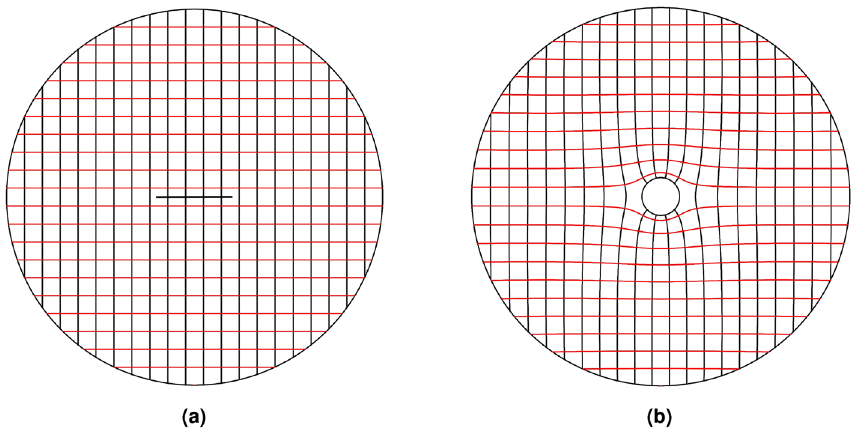
Figure 4. Grid transformation between the virtual and physical spaces. ( a ) Cartesian grids in the virtual space, and ( b ) the corresponding mapped ones in the physical